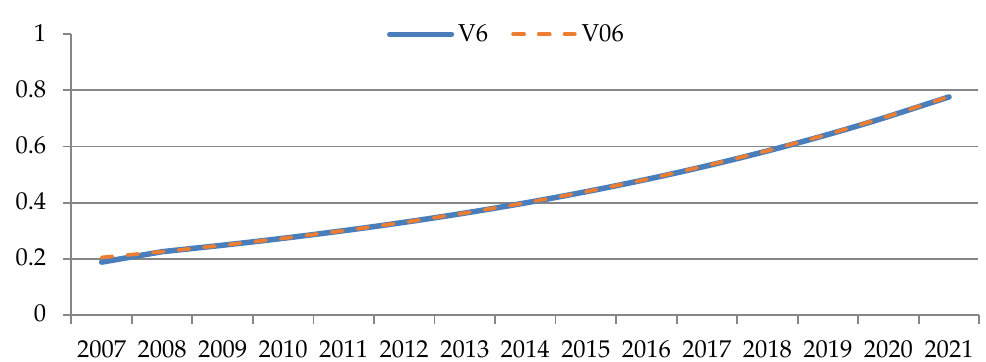
Figure 12. Graphs for tracking the target revenue indicator for industry No. 6 (author’s results). The efficiency indicator takes a value from 0 to 1. The closer it is to 1, the more efficient the enterprise is, and vice versa, if it is closer to 0, then it is less efficient. To solve the problem, the parameter was set equal to 0.5, eff = 0.5 , since it is the average value of the efficiency indicator.